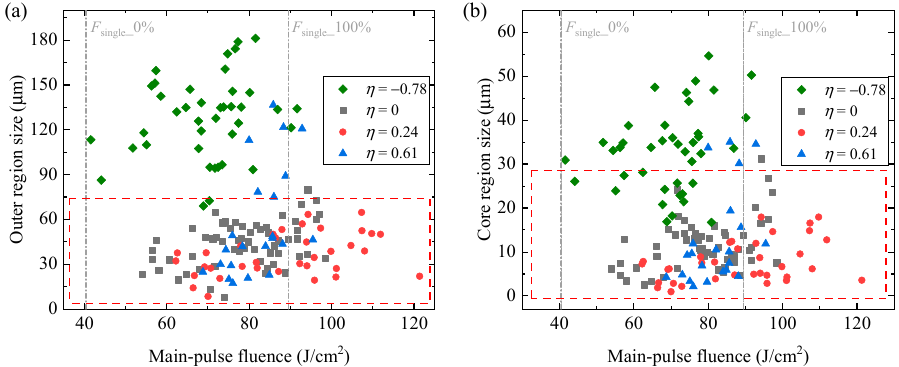
Figure 6. Size distributions of ( a ) the outer and ( b ) core regions of the damage sites on main-pulse fluence for η = − 0.78, η = 0 (single-pulse), η = 0.24 and η = 0.61.